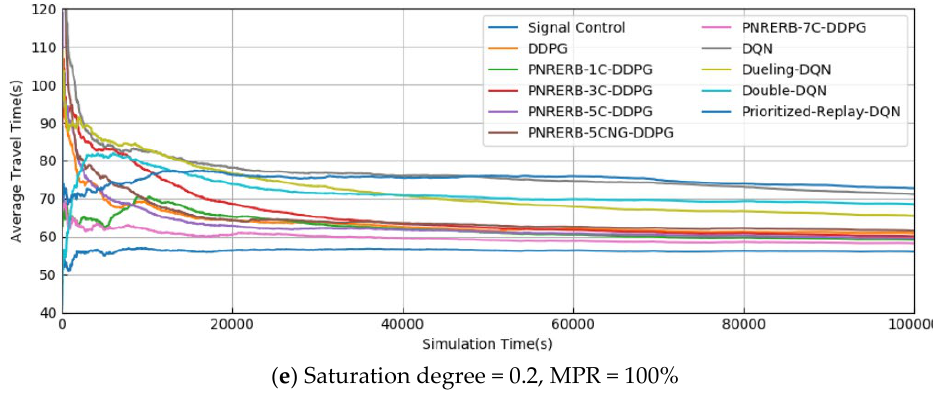
Figure 4. Average travel time (ATT) results for different CAV market penetration rates (MPRs) under 0.2 saturation.